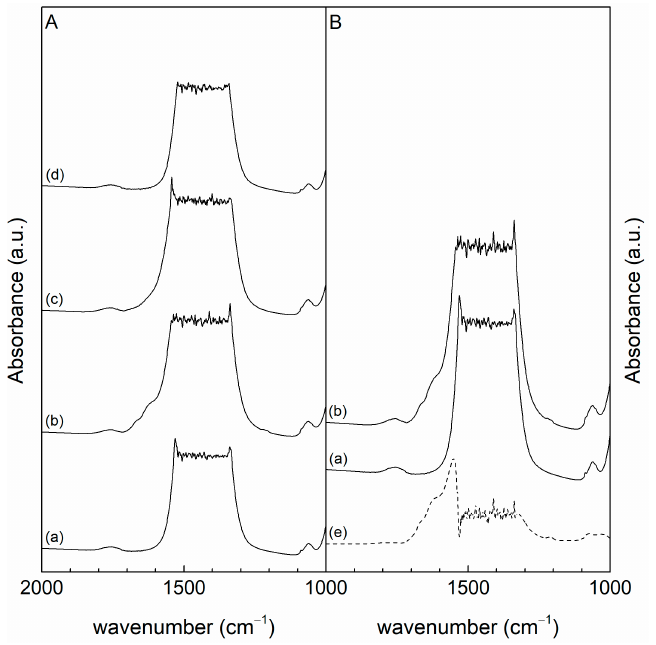
Figure 4. FTIR spectra at RT after outgassing at 450 °C (a), exposure to CO 2 (b), and subsequent outgassing at RT (c) and 450 °C (d).